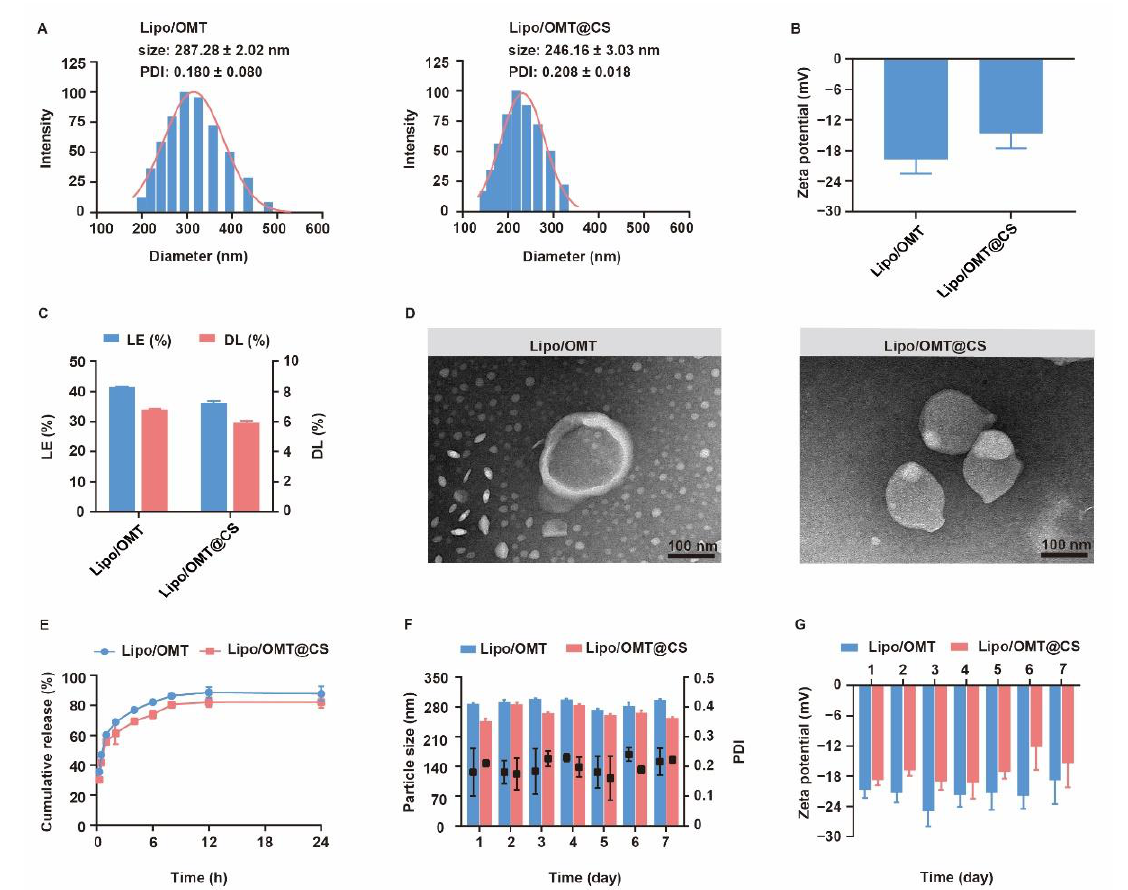
Figure 3. Characterization of OMT liposomal preparations. ( A ) Evolution of particle size, PDI and ( B ) zeta potential of OMT liposomal preparations. ( C ) Drug loading efficiency (LE) and drug loading capability (DL) of OMT liposomal preparations. ( D ) Representative TEM images of Lipo/OMT and Lipo/OMT@CS (scale bar 100 nm). ( E ) In vitro release behavior of OMT from liposomal preparations in pH 7.4 PBS. ( F ) The variation in particle size, PDI and ( G ) zeta potential of OMT liposomal preparations, at 4 °C, for 7 days. All the data were expressed as mean + SD ( n = 3).